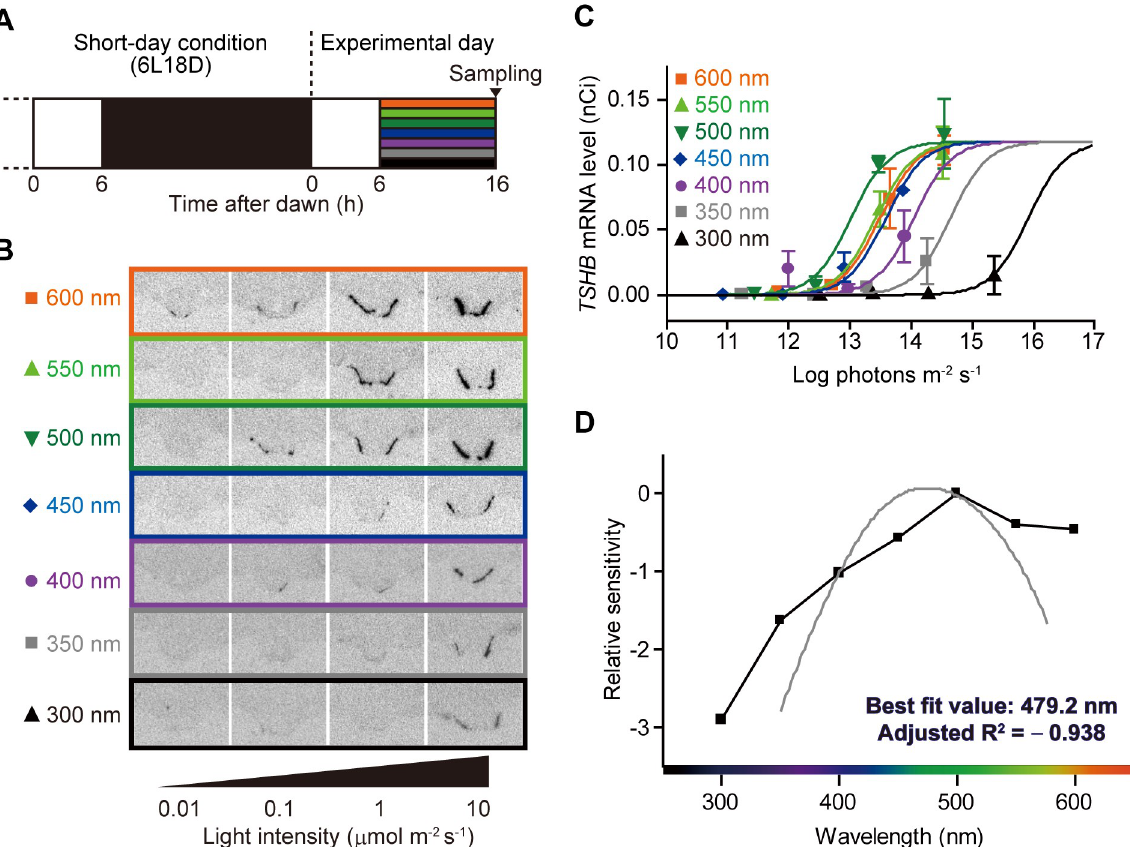
Fig 2. The action spectrum using the photoperiodically induced beta subunit of thyroid-stimulating hormone. ( A ) Schedule for light exposure and sampling. Eye-patched birds lacking pineal organ and maintained under short-day conditions (6 h:18 h light/dark cycle: 6L18D) were given a long-day stimulus by extending the 6-h light period by 10 h with light of seven different wavelengths. ( B ) The effects of four intensities of light at each wavelength on the expressions of photoperiodically induced mRNA encoding the beta subunit of thyroid-stimulating hormone ( TSHB ) in the pars tuberalis of the pituitary gland were evaluated by in situ hybridization. ( C ) Each expression level of TSHB was plotted to examine the dependence of photoperiodic responses on irradiance with monochromatic lights of seven different wavelengths. Each light intensity (photons m 2 s -1 ) was adjusted to the light intensity at the deep-brain region level using the percentage of T/T max . Each point represents the mean ± SEM (n = 4). ( D ) The action spectrum for photoperiodic TSHB induction. The half-saturation constant (EC 50 ) derived from sigmoidal fits of the light intensity–response curves were plotted against wavelength. The action spectrum was then fitted with a curve for retinal1-based photopigment using the least-squares method. Peak sensitivity was approximately 479.2 nm with a low value for the goodness of fit (adjusted R 2 =